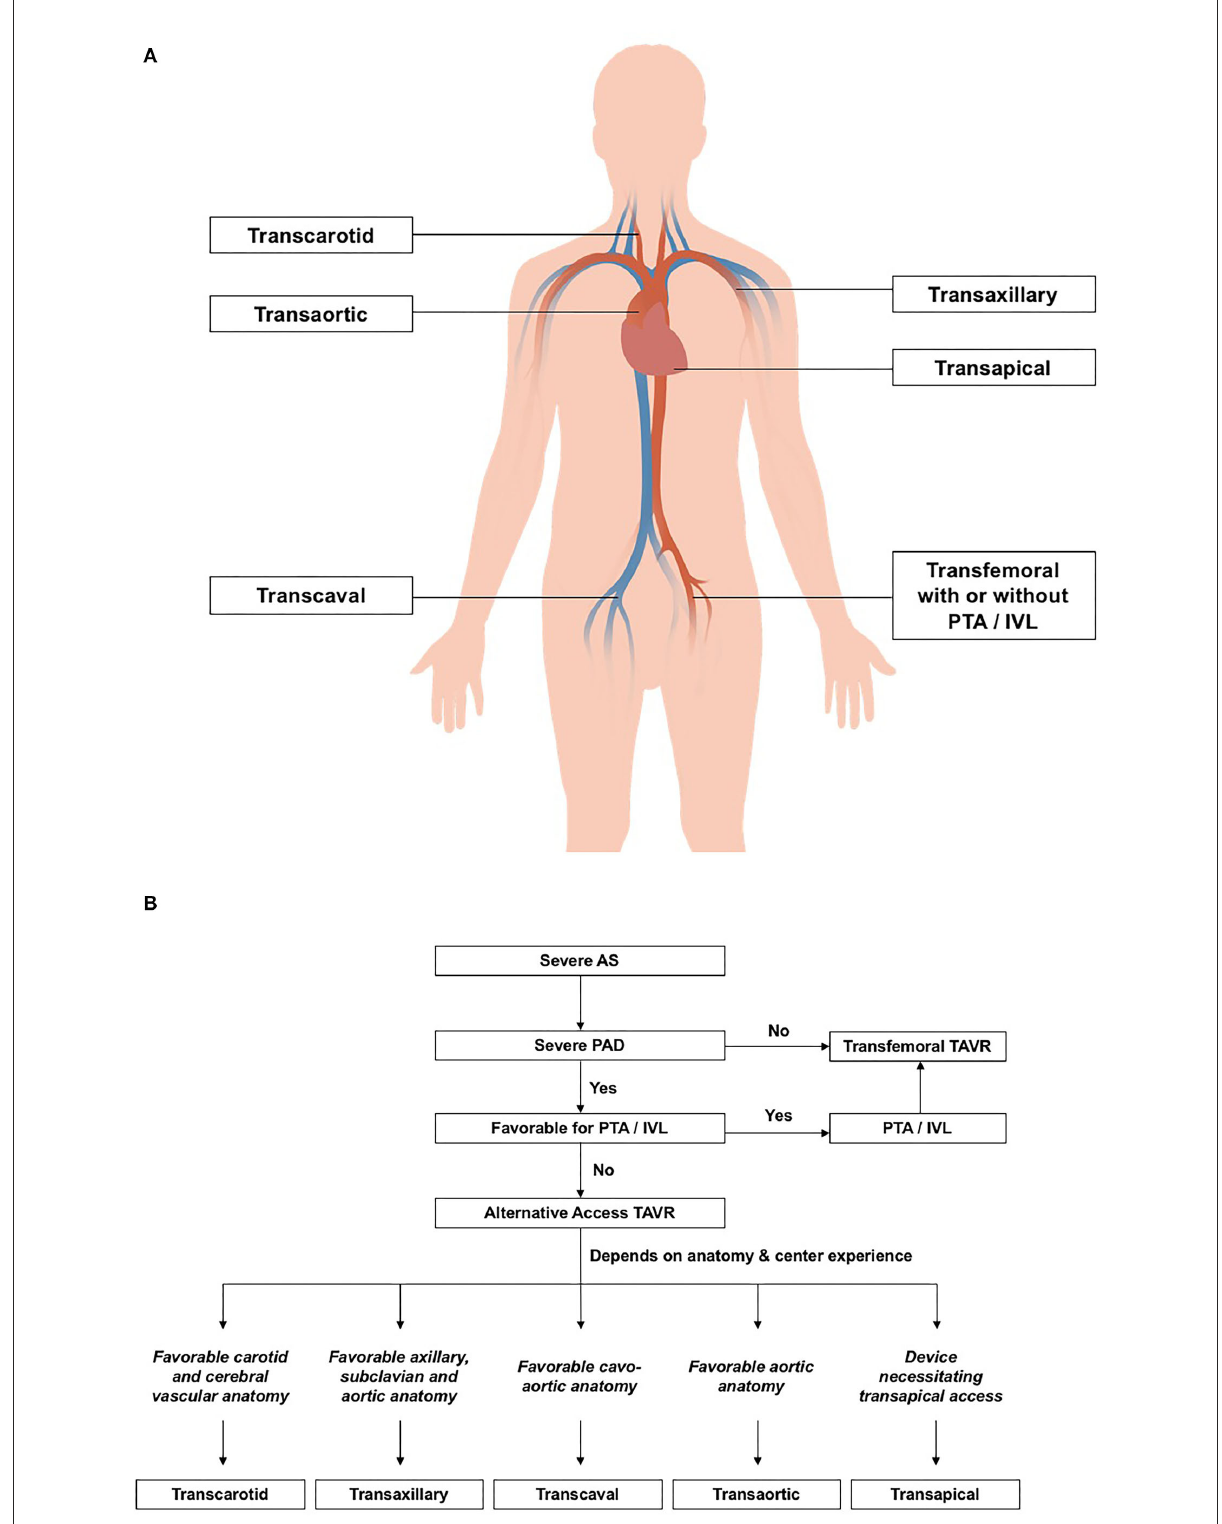
FIGURE1 (A) Transcatheter aortic valve replacement (TAVR) strategies in patients with concomitant peripheral arterial disease. (B) Anatomical factors for deciding vascular access for TAVR. AS, aortic stenosis; IVL; intravascular lithotripsy; PAD, peripheral arterial disease; PTA, peripheral transluminal angioplasty; SFAR, Sheath-to-femoral ratio; TAVR, transcatheter aortic valve